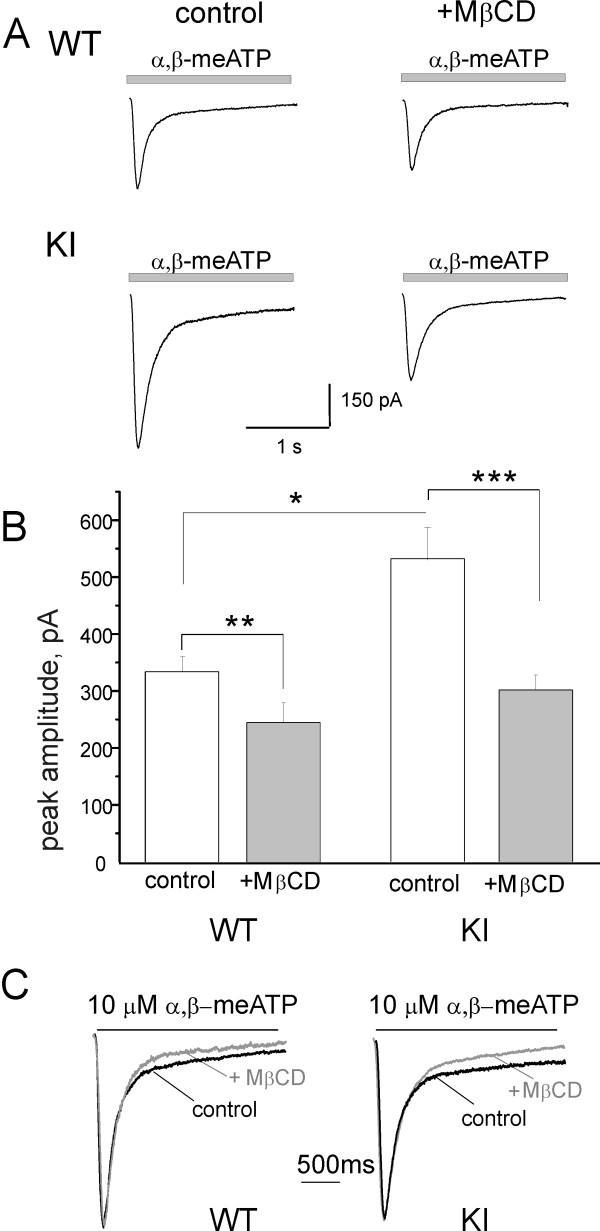
Patch clamp recording from WT and KI cultured neurons. A, Representative current traces evoked by α,β-meATP (10 μM, 2 s) from WT and KI neurons in control and after MβCD pre-treatment (30 min, 10 mM). B, Histograms quantify the current amplitude before or after MβCD pre-treatment for WT and KI neurons. Control: n = 33 for WT and KI. *: p = 0.006. **:p = 0.008; ***: p = 0.002. MβCD: n = 30 for WT and KI. C, P2X3 mediated current traces (average of 14-20 responses) in control (black) and after MβCD pre-treatment (gray), normalized and overlapped, from WT (left) and KI (right) neurons. Note no change in the current onset, and clear acceleration of its slow decay.